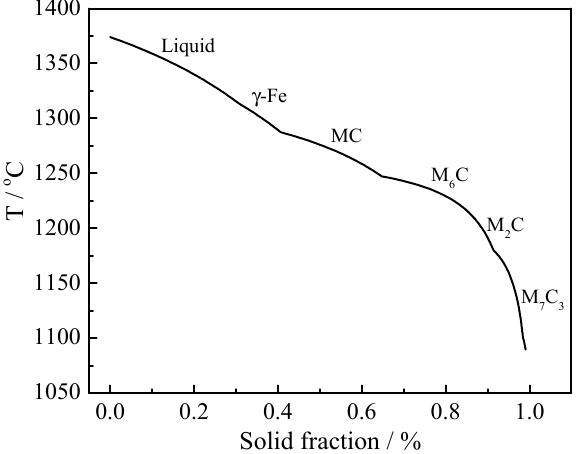
Figure 8. Non-equilibrium phase diagram in HSS. Table 4. Calculation results of non-equilibrium phase precipitation using Thermo-Calc.